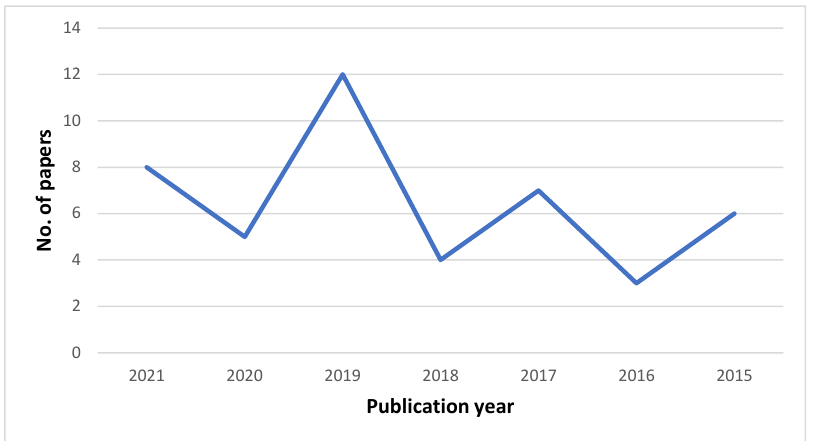
Figure 3. Studies’ distribution by publication year.